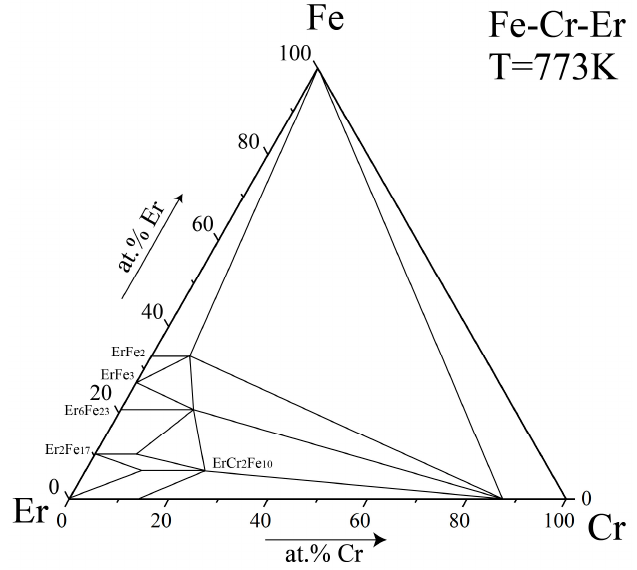
Figure 4. Isothermal section of Fe–Cr–Er ternary system at 773 K by Pan et al. [27]. Table 1. Experimental and literature data on crystal structures and lattice parameters of the solid phases in the Fe–Cr–Er system.